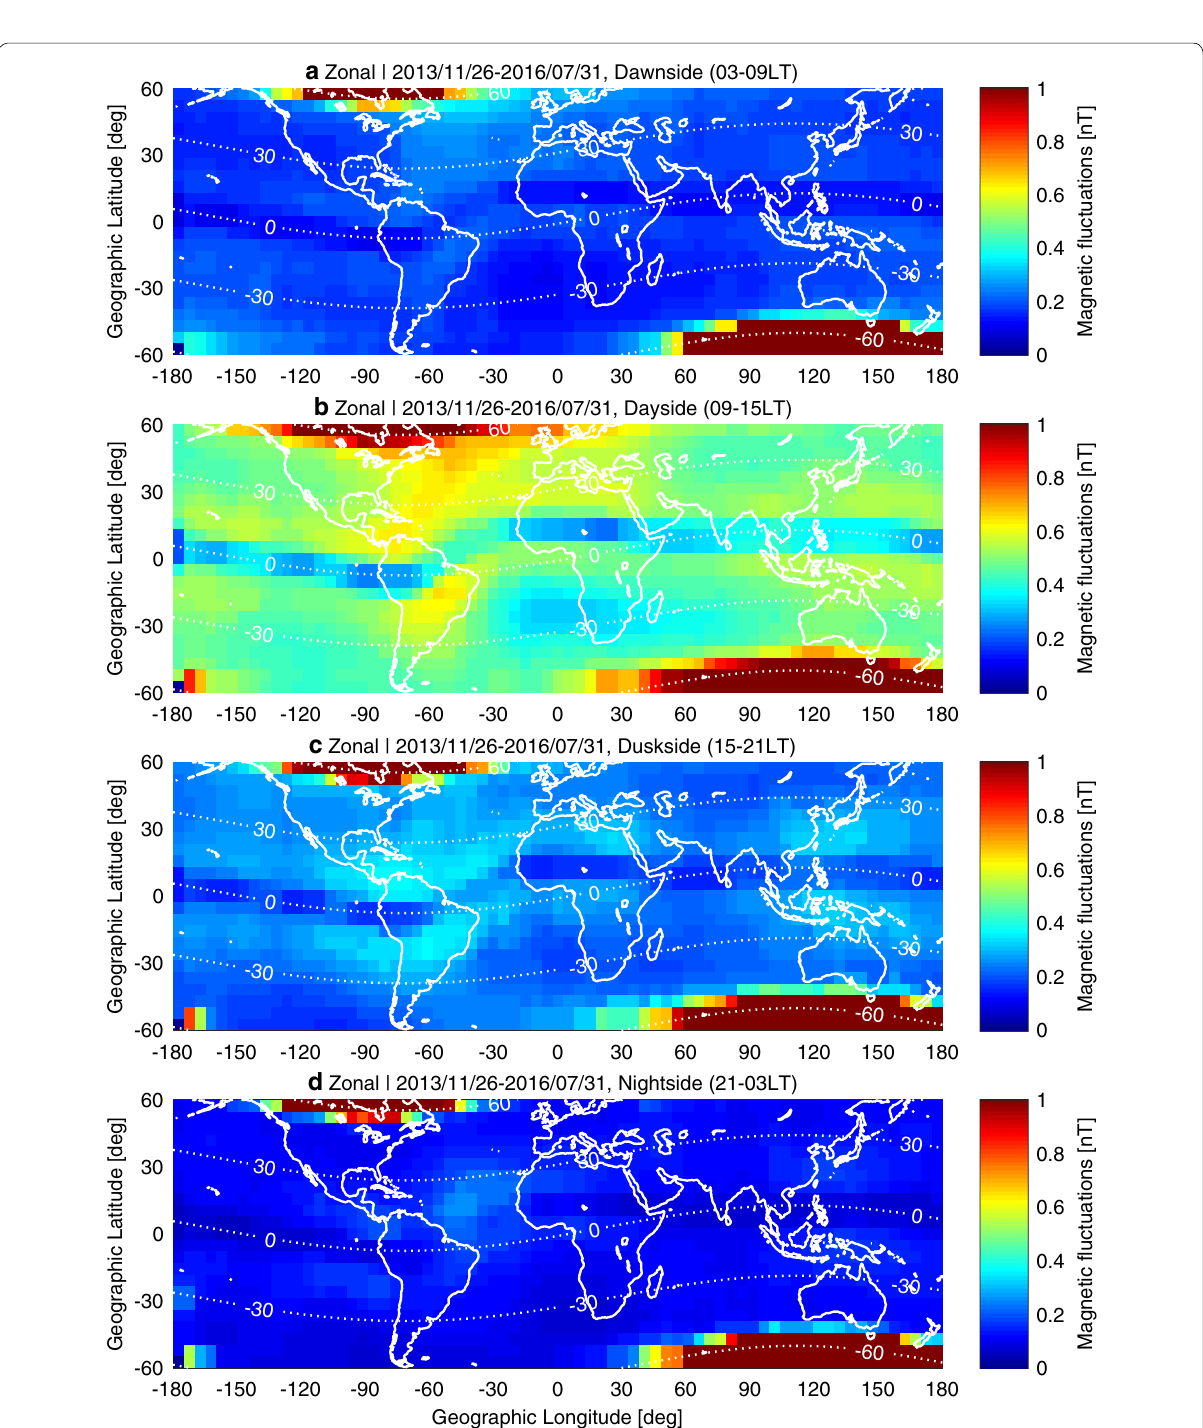
Fig. 1 LT dependence of the average MR amplitude distribution as observed by SW-A, SW-B, and SW-C. a Dawn side (3–9 LT), b day side (9–15 LT), c dusk side (15–21 LT) and d night side (21–3